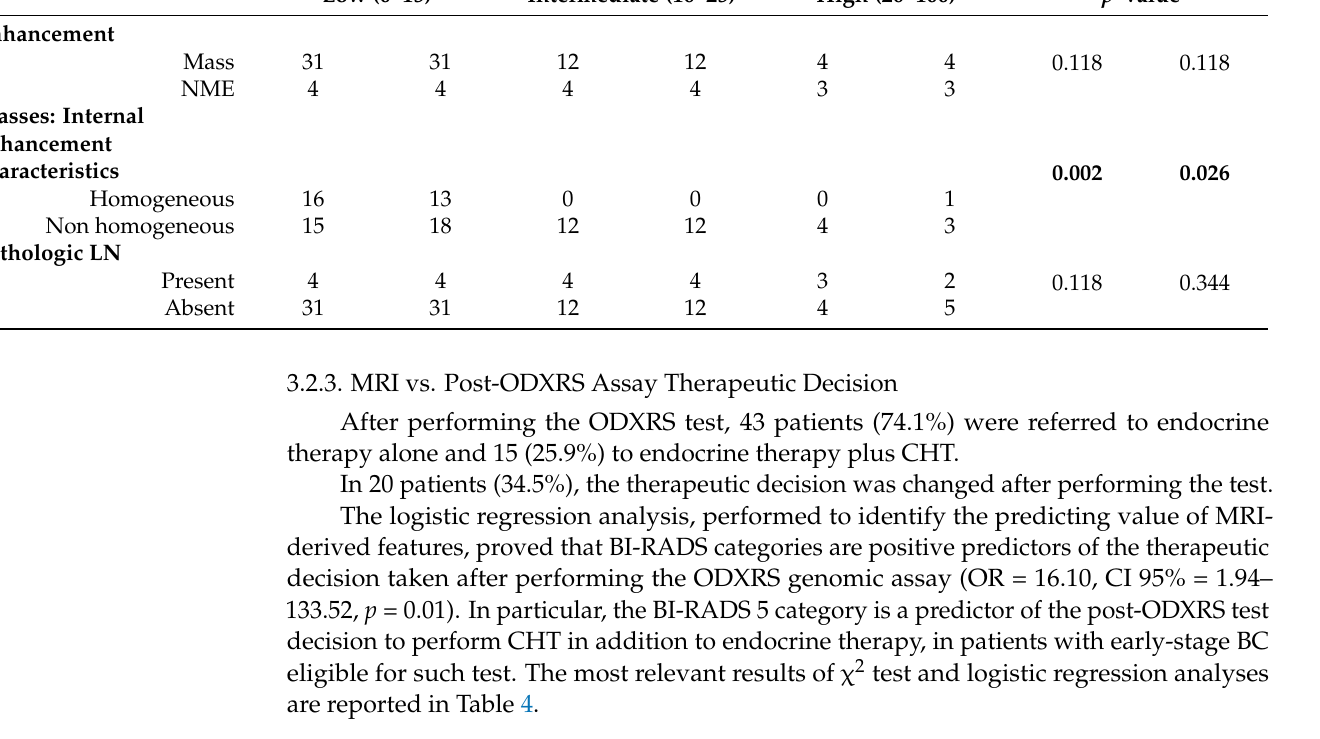
Table 4. Association between pathological and MRI-derived features and post-ODXRS therapeutic decision. Statistically significant results were further evaluated using univariate analysis. Variables that were significant in univariate analysis were included in multivariate analysis. Statistically significant results are